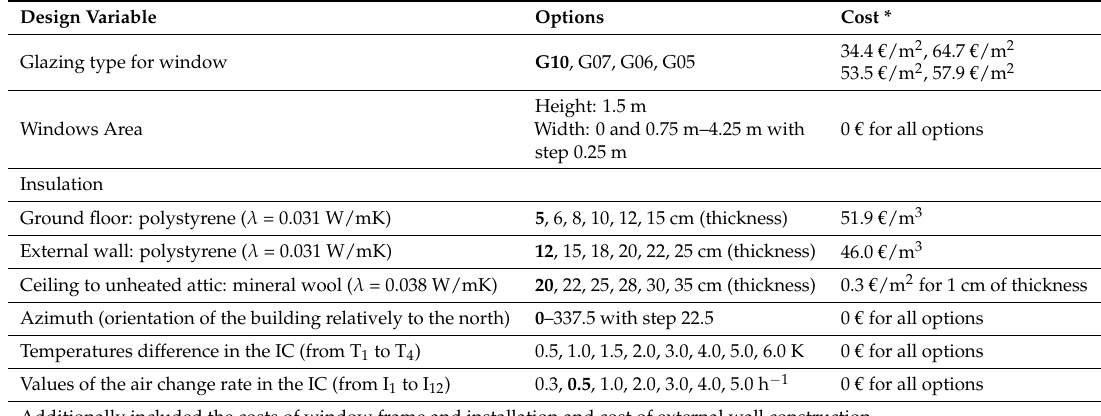
Table 2. Cost data for design variables and options used for the optimization